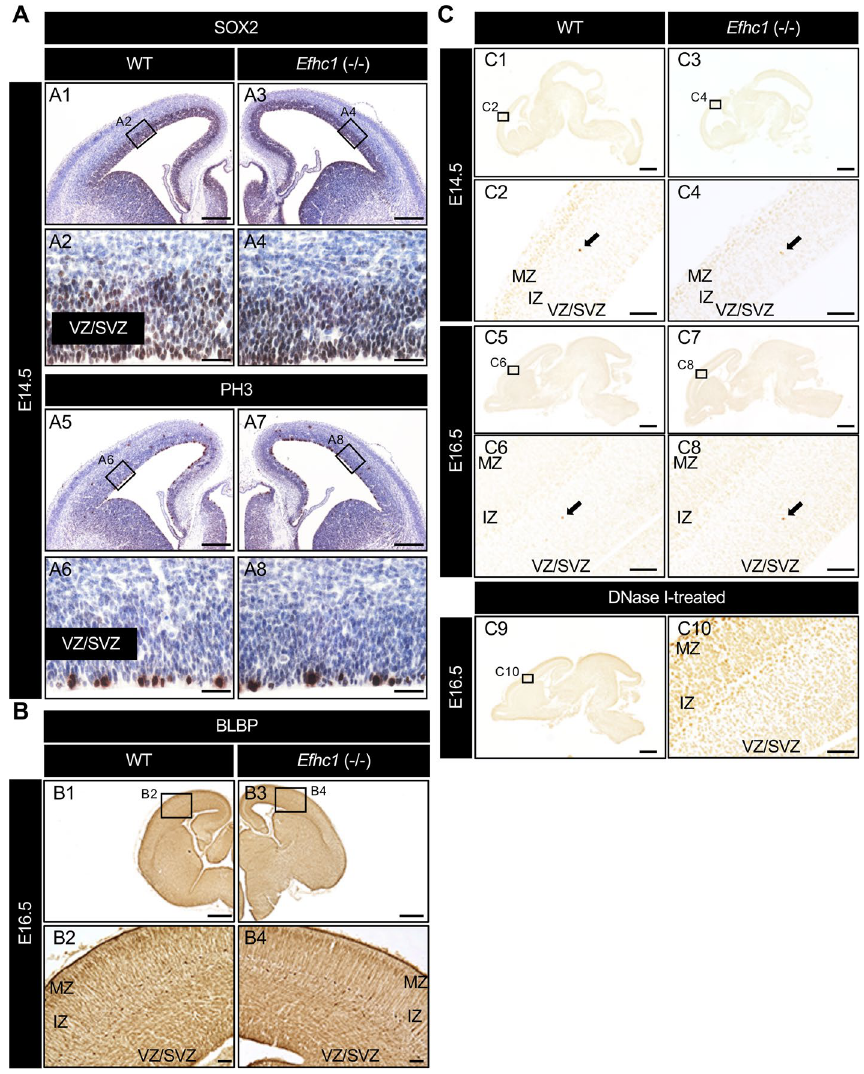
Figure 4. No visible abnormalities in cortical development of Efhc1 −/− mouse. ( A ) DAB-staining of coronal brain sections from E14.5 WT and Efhc1 −/− mice with antibodies to SOX2 or PH3 (two independent experiments, N = 3 WT and 3 Efhc1 −/− ). Nuclei were stained with hematoxylin (blue). SOX2 and PH3 expressions were observed at ventricular zone (VZ)/sub ventricular zone (SVZ). Note that there were no visible differences in their distributions between WT and Efhc1 −/− . A2, A4, A6 and A8: magnified images outlined in A1, A3, A5 and A7, respectively. ( B ) Coronal brain sections from E16.5 WT and Efhc1 −/− mice were DAB- stained with antibody to BLBP (two independent experiments, N = 1 WT and 1 Efhc1 −/− ). No obvious difference of radial glia process extension was observed between WT and Efhc1 −/− . B2 and B4: magnified images outlined mice (two independent experiments, N = 2 WT and 2 Efhc1 −/− for E14.5; N = 1 WT and 1 Efhc1 −/− for